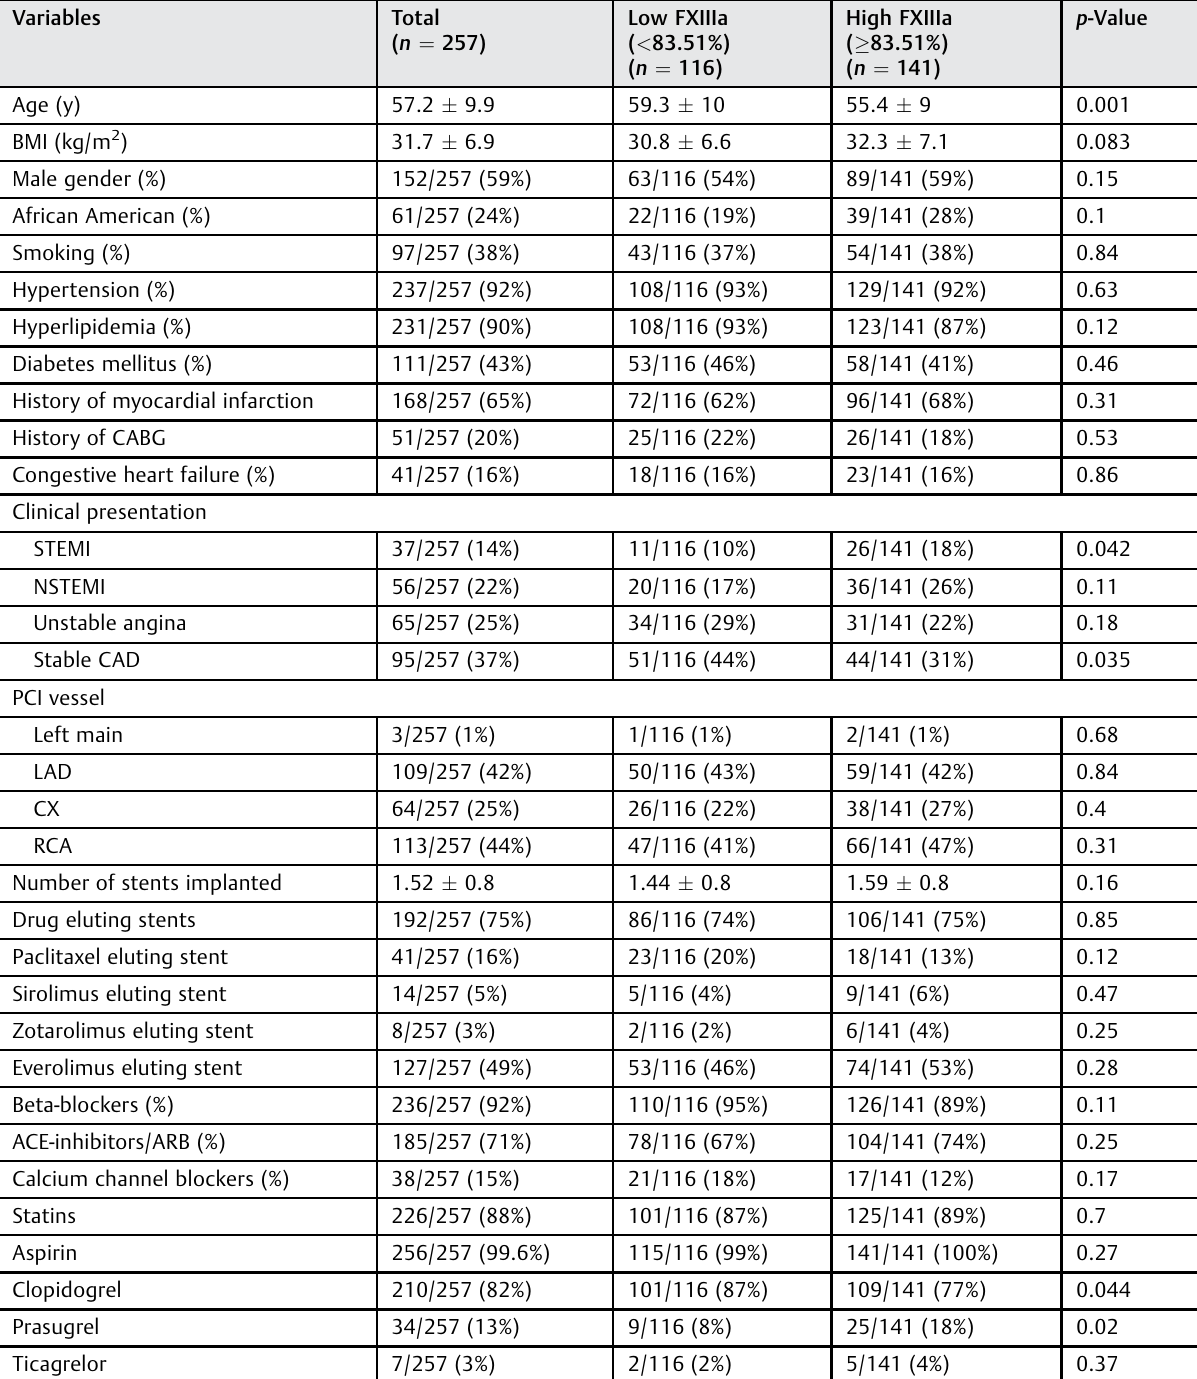
Table 1 Baseline demographics and clinical variables for total study population, and grouped according to low and high FXIIIa